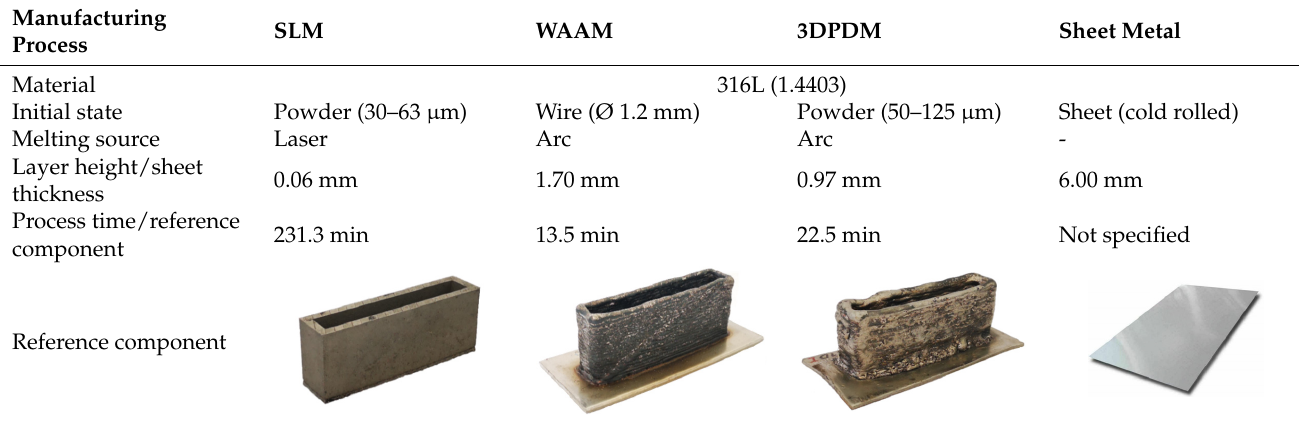
Table 1. Characteristics of the additive processes investigated in the study.